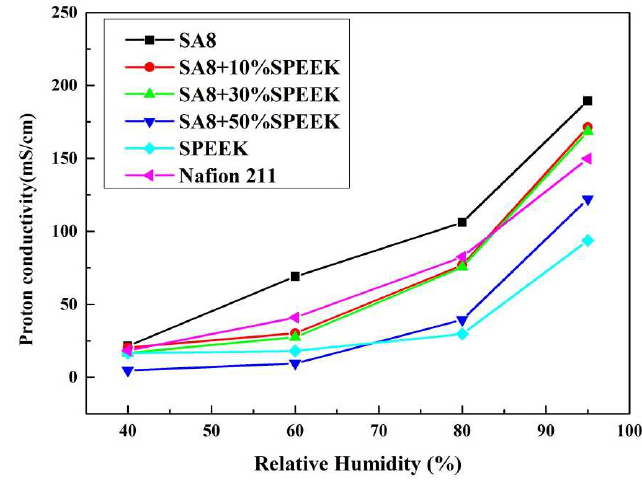
Figure 21. The proton conductivity diagram of SA8 blended with sPEEK.